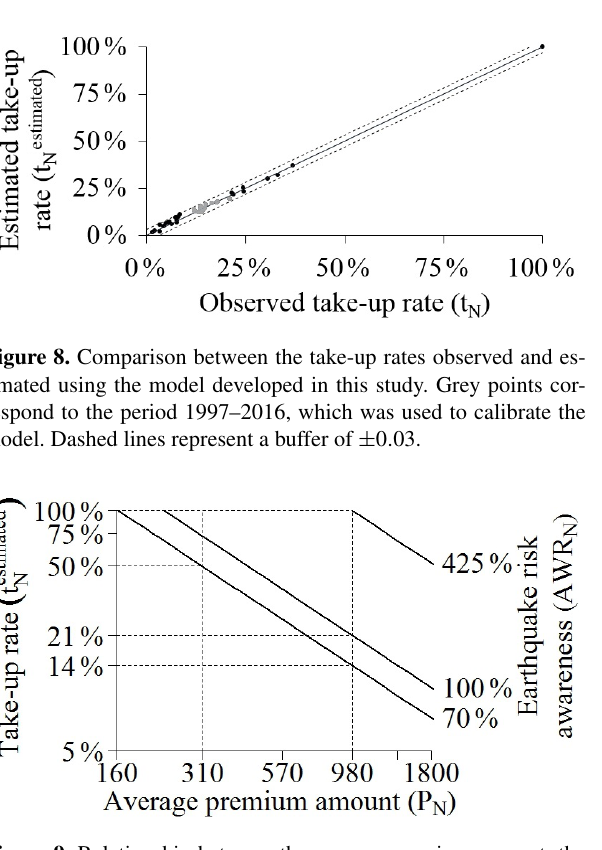
Figure 9. Relationship between the average premium amount, the take-up rate and the earthquake risk awareness. Financial values are in US dollars